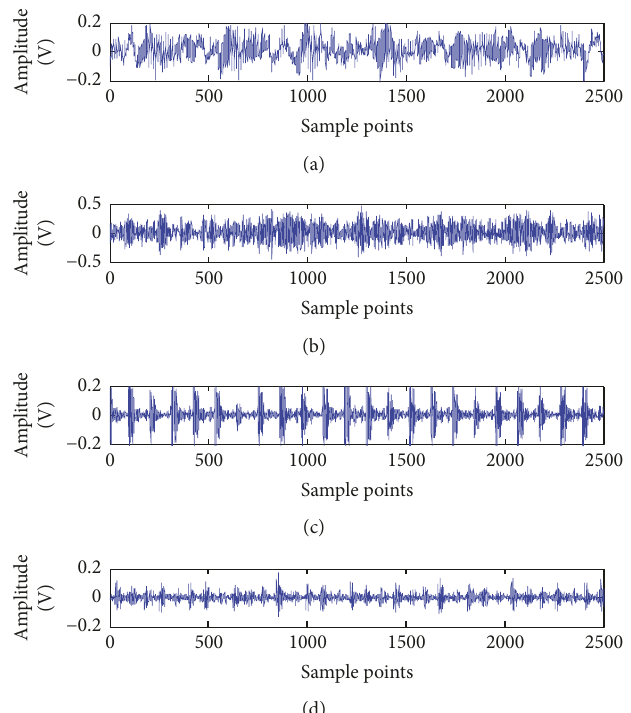
Figure 6: Four vibration signals collected by the sensor: (a) normal, (b) rolling element fault, (c) outer race fault, and (d) inner race fault.